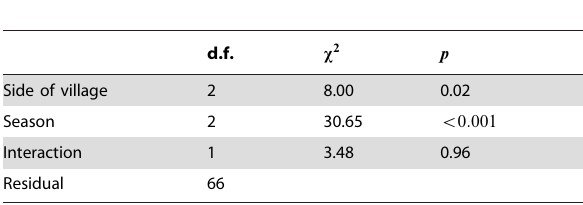
Table 2. Effect of side and season on dispersal